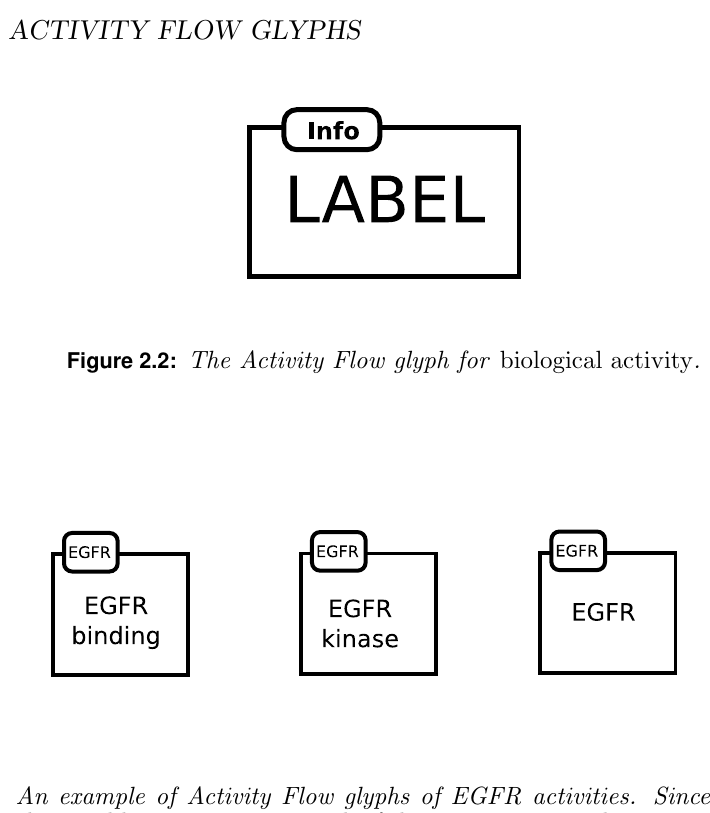
Figure 2.4: The Activity Flow glyph for phenotype